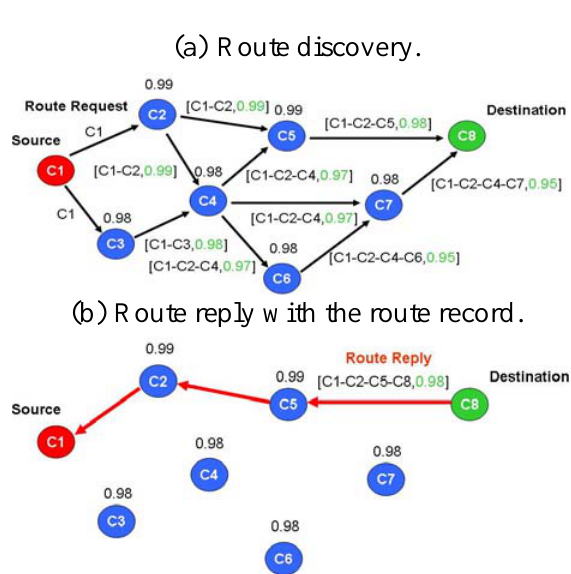
Figure 14. DSR operations. (a) Route discovery.